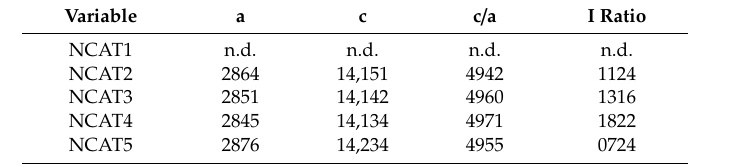
Table 2. Lattice parameter NCA samples at various sintering temperatures.